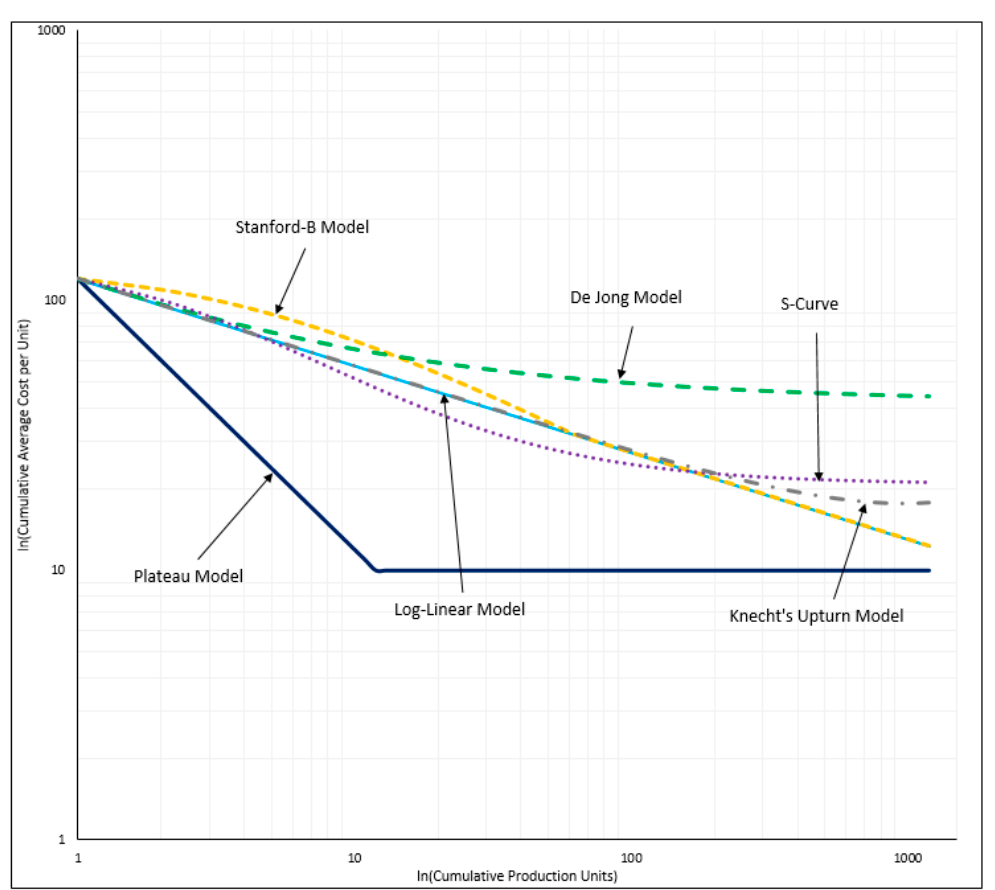
Figure 3. Comparison of Learning Curve Models (adapted from Badiru [27]).